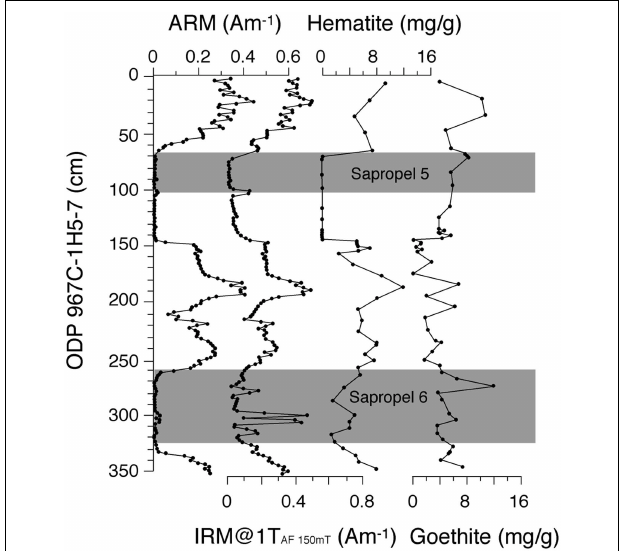
FIGURE 4 | Variations in magnetite/maghemite (ARM), hematite (IRM@AF and DRS data), and goethite (DRS data) abundances across sapropels 5 and 6 (data from Liu et al., 2012b).